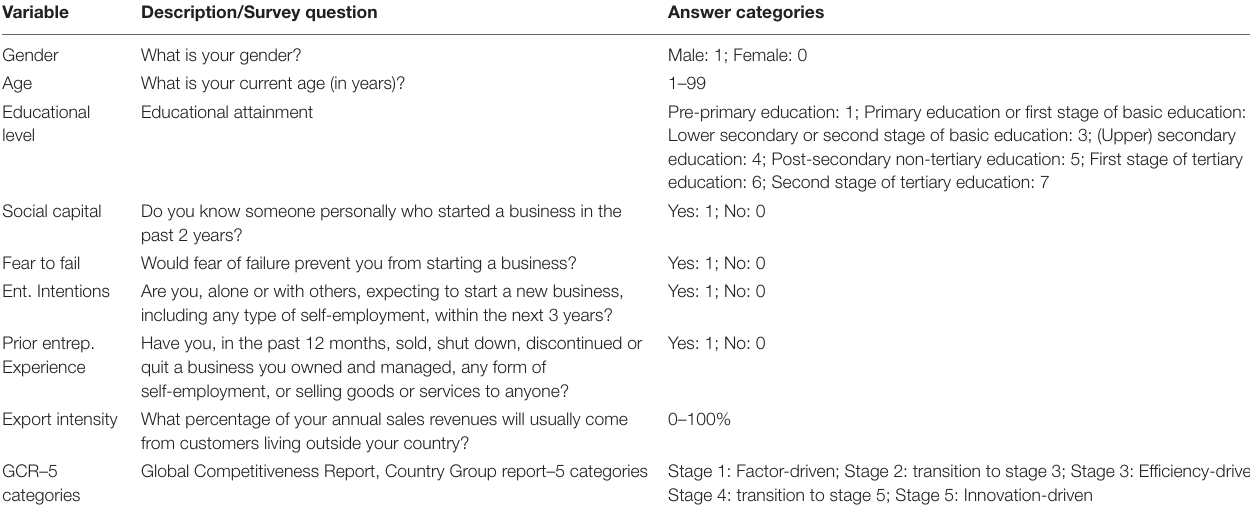
TABLE 1 | Description of the control